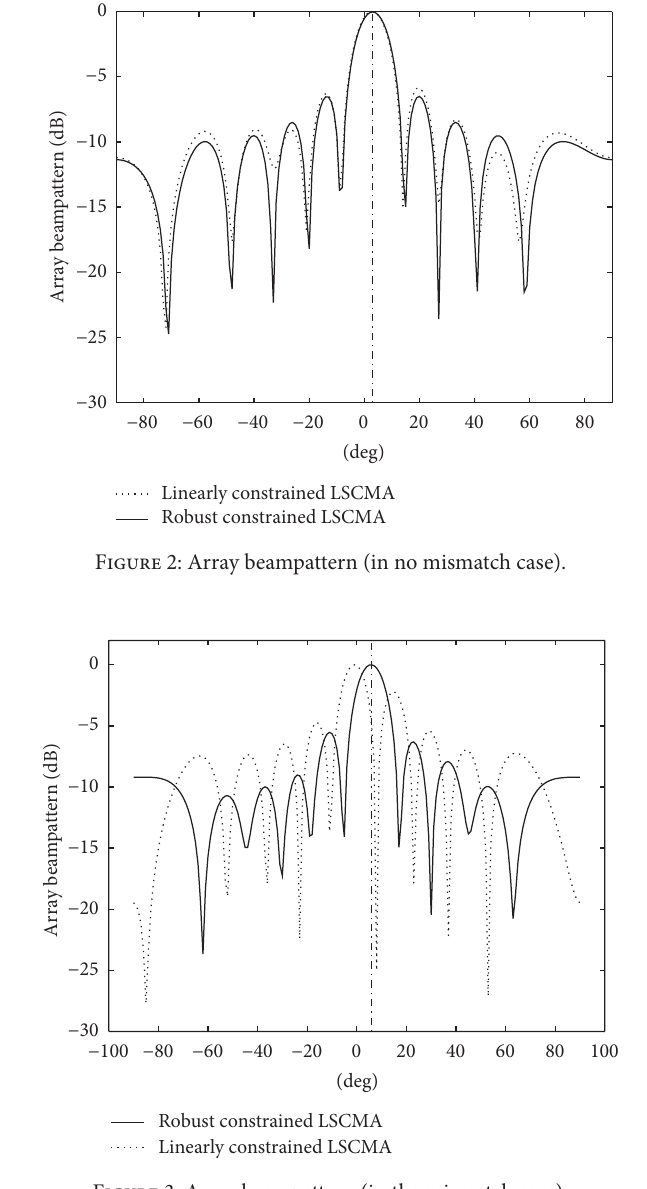
Figure 3: Array beampattern (in the mismatch